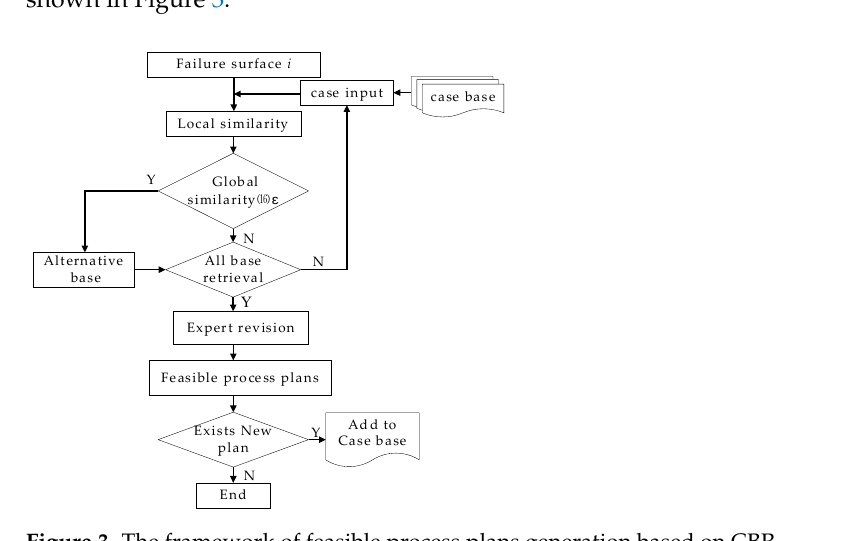
Figure 3. The framework of feasible process plans generation based on